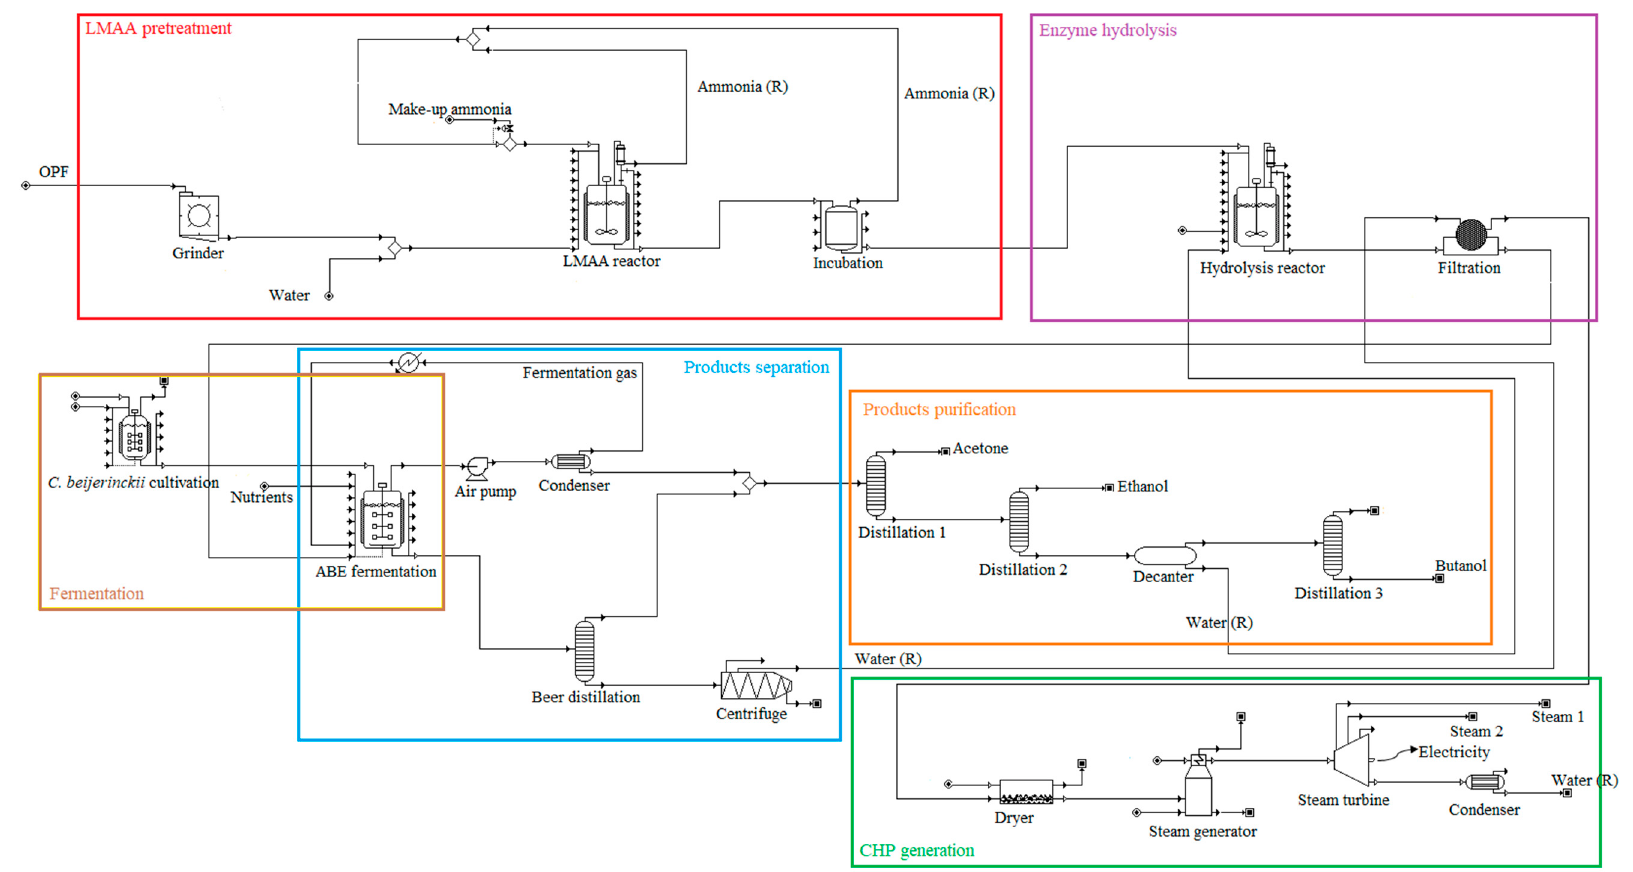
ff erent colored boxes denote di ff erent production stages; (R) =